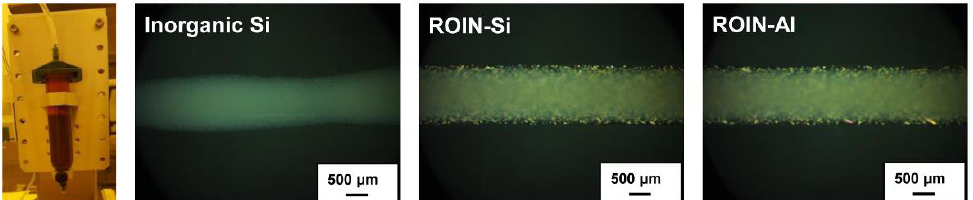
Figure 6. Microscopic images of dispensing lines after drawing the sealing composites with inorganic Si, ROIN-Si, and ROIN-Al nanoparticles between two glass substrates using commercial seal dispenser.